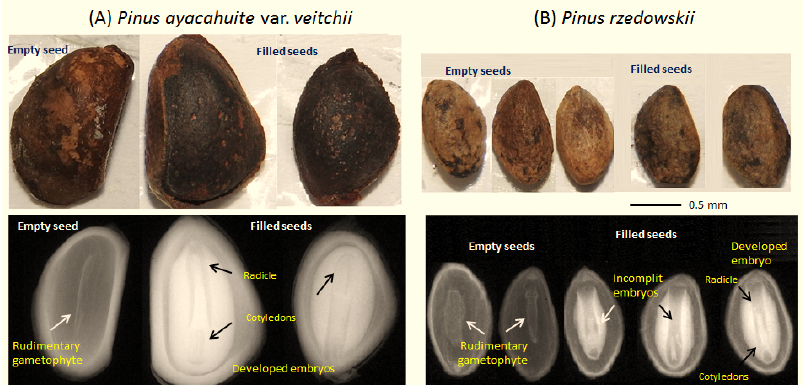
Figure 2. Radiographic images of developed seeds: ( A ) Ayacahuite pine seeds, showing empty seeds with rudimentary gametophyte and filled seeds with completely developed embryons; and ( B ) Rzedowski’s pine seeds, showing empty seeds with rudimentary gametophyte and filled seeds with non ‐ fully developed embryo and completely developed embryo.